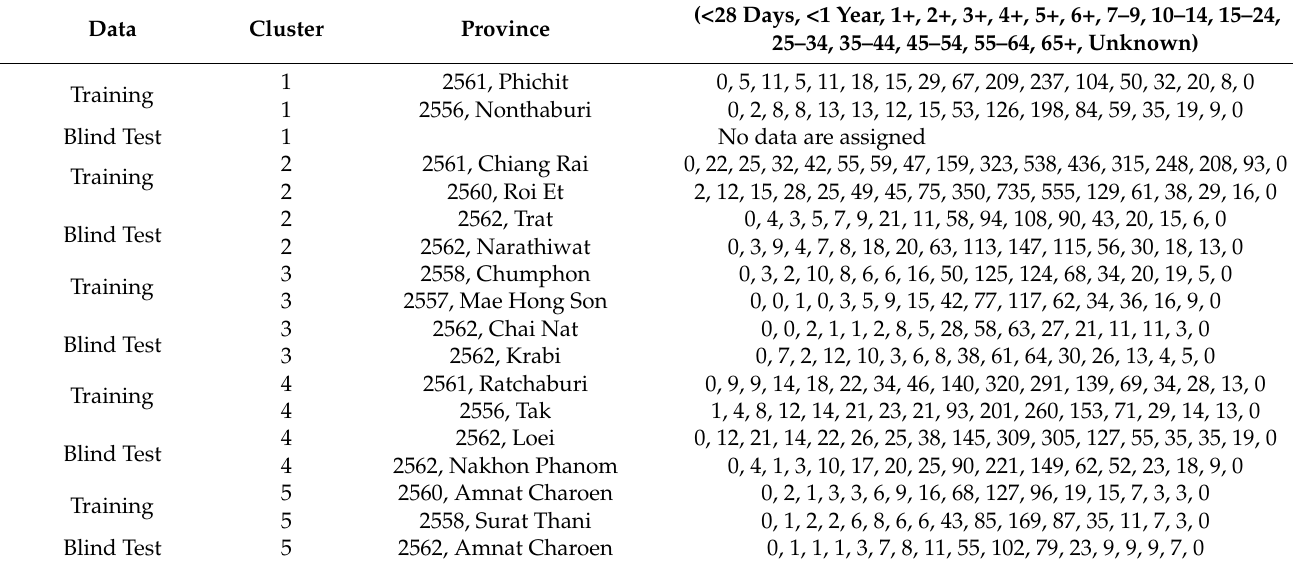
Table 9. The example of clustering results from the selected models for the dengue fever dataset for the age range category.